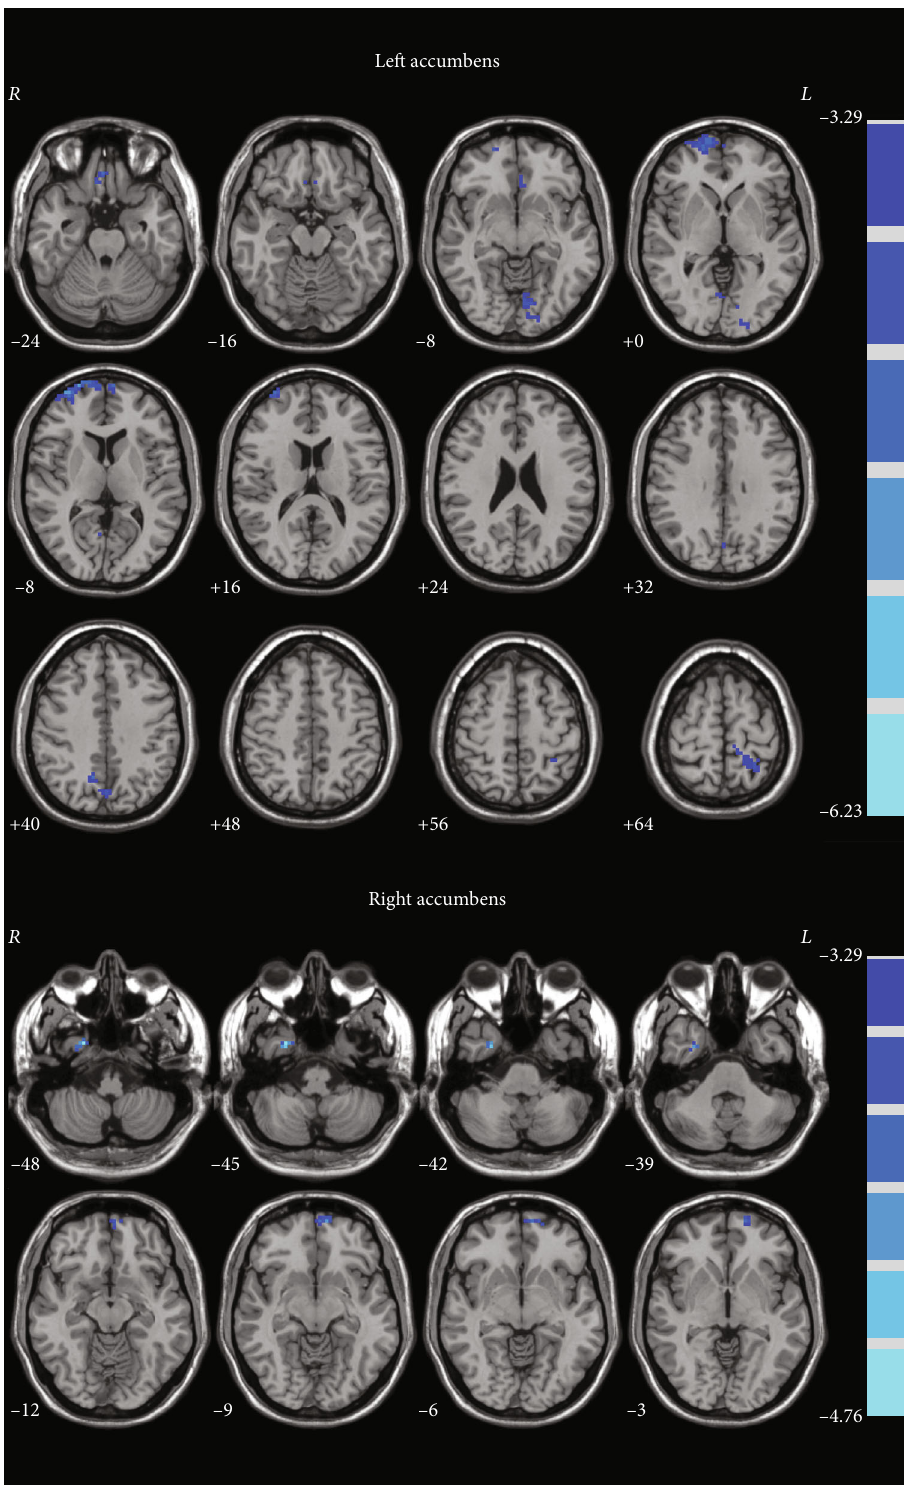
Figure 1: Brain regions with signi fi cant di ff erences on seed-based functional connectivity in OCD. The color bar indicates the T values from two-sample t -tests. The blue color denotes decreased functional connectivity values in the patients. OCD: obsessive-compulsive